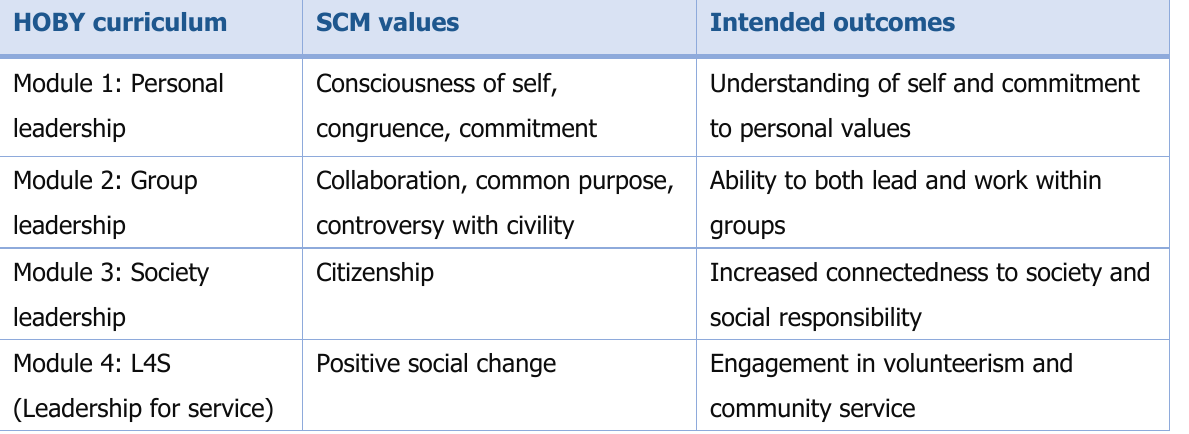
Table 1. SCM of Leadership Values and Subsequent HOBY Module